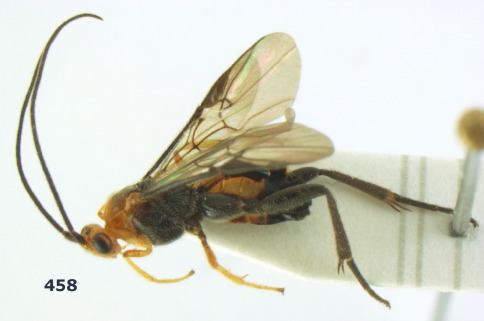
Zelodia microcellata gen. n. sp. n., male, holotype. Habitus lateral.